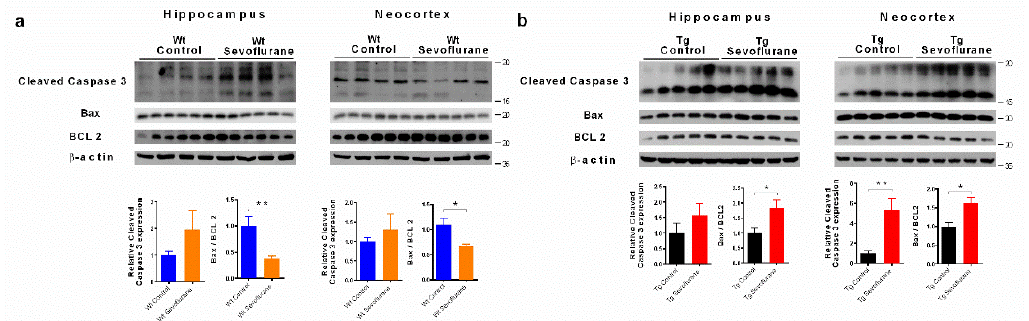
Figure 5. Sevoflurane activated the apoptotic pathway in 3 × Tg but not in wild-type mice. Cleaved caspase 3 and BAX/Bcl2 proteins were examined in the hippocampus and neocortex of wild-type and 3 × Tg mice. ( a ) No significant change in the cleaved caspase 3 was in line with a reduction in the BAX/Bcl2 ratio in wild-type mice. ( b ) Significant elevation of cleaved caspase 3 protein and BAX/Bcl2 ratio in 3 × Tg mice. Bar graphs below show the quantification of Western blot. Data correspond to the mean ± SEM ( n = 5–6) and represent the band densities that were normalized with the endogenous loading control. * p < 0.05, ** p < 0.01 in comparison to the control. Values were analyzed using the unpaired t -test.